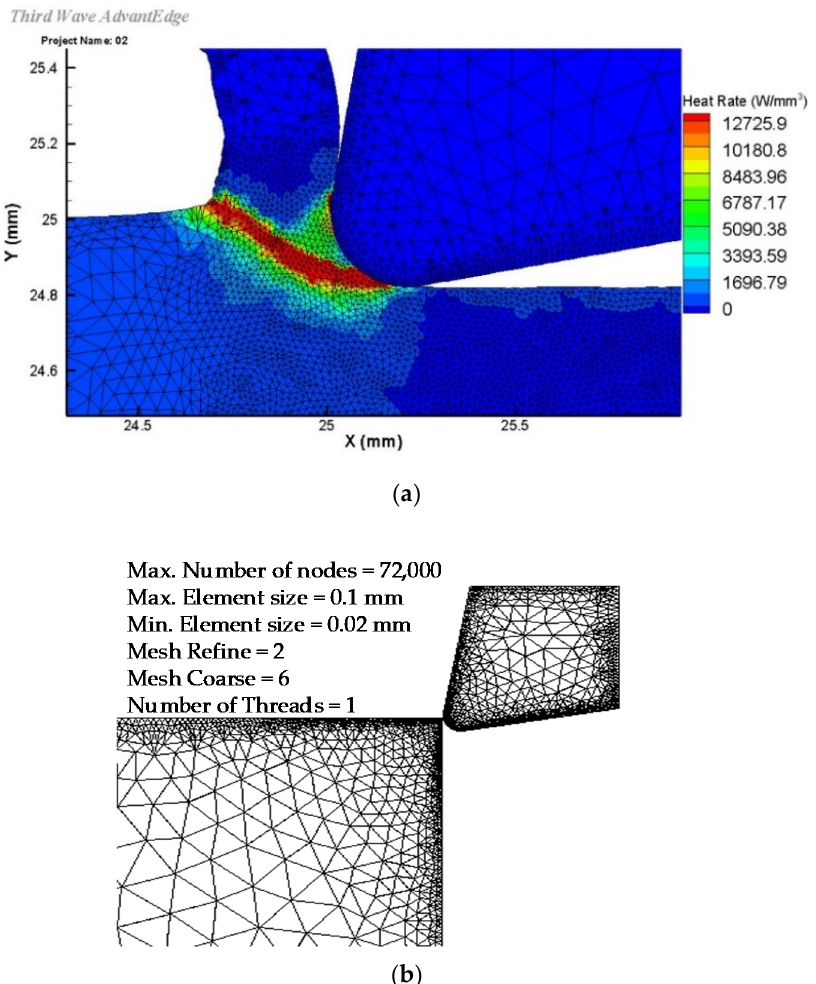
Figure 2. ( a ) Example of mesh in tool, chip and work piece during simulation; ( b ) Example of mesh in tool and work piece.